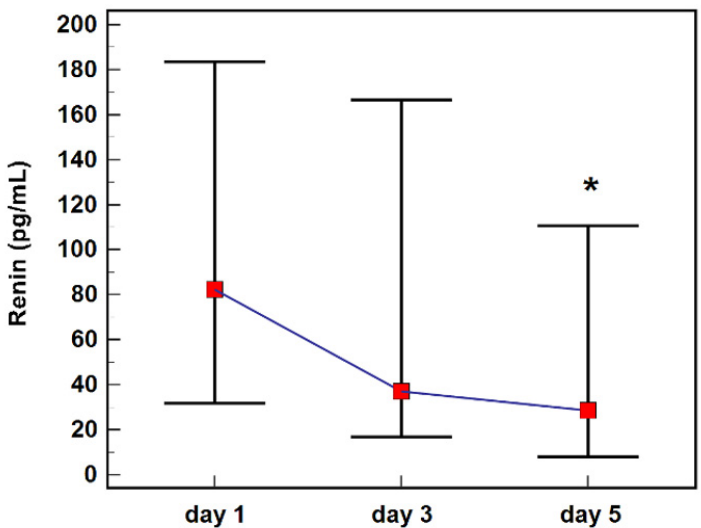
Figure 3. Renin concentration during a follow-up. Notes: Data analyzed using Friedman tests, and are presented as medians (red squares) with interquartile ranges (black whiskers). *, significantly ( p < 0.05) different from measurements at day 1 and 3. Table 2. Correlation between renin and biochemical and clinical parameters during a